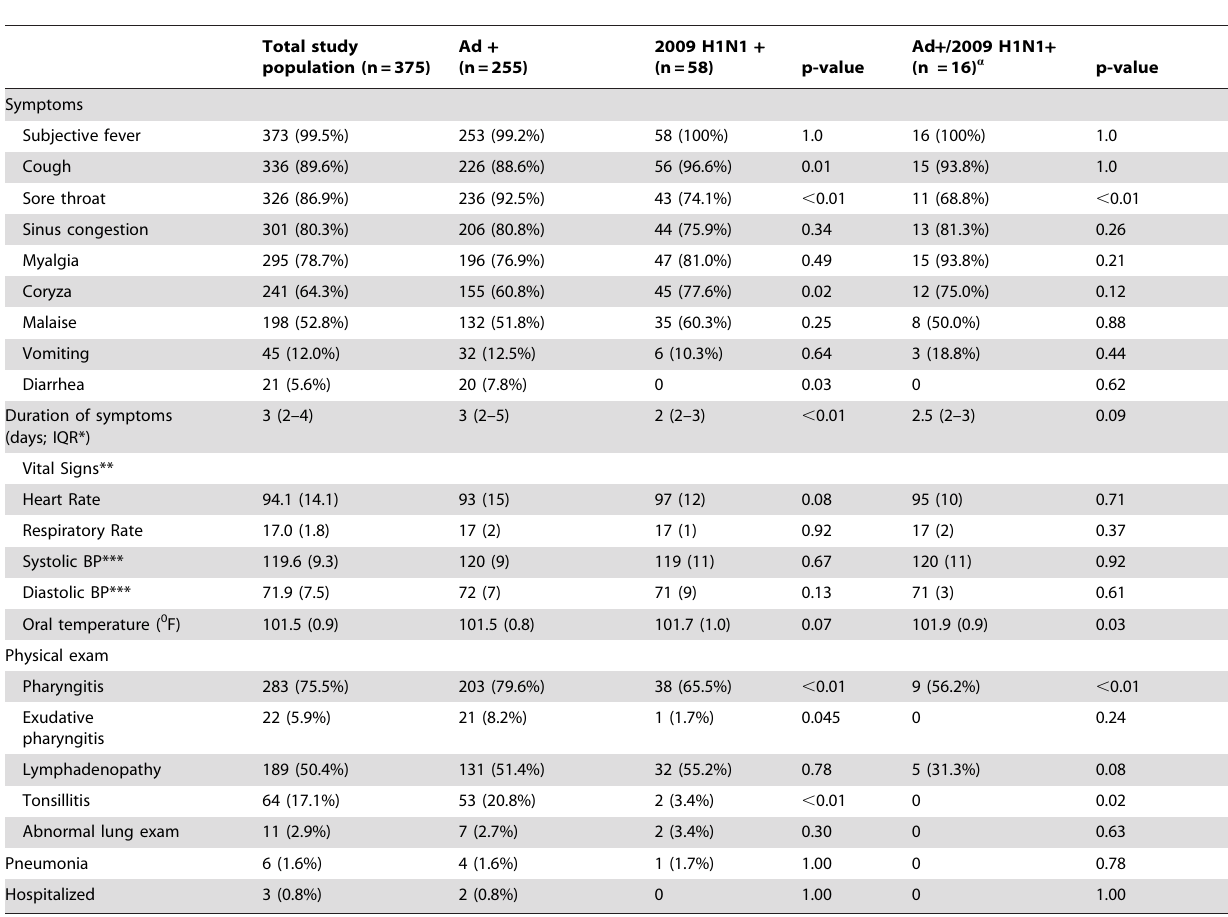
Table 4. Clinical characteristics of total study population, and comparison of clinical variables: Adenovirus (Ad) vs. 2009 H1N1, and coinfection vs. Ad